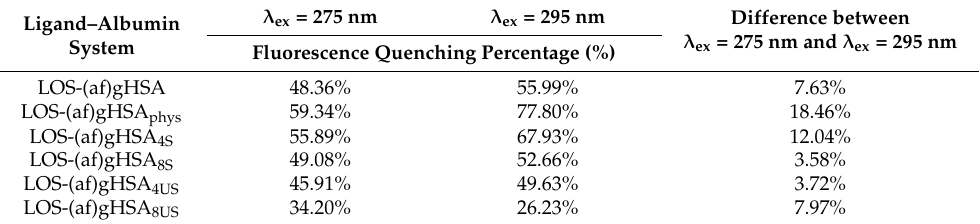
λ ex = 275 nm λ ex = 295